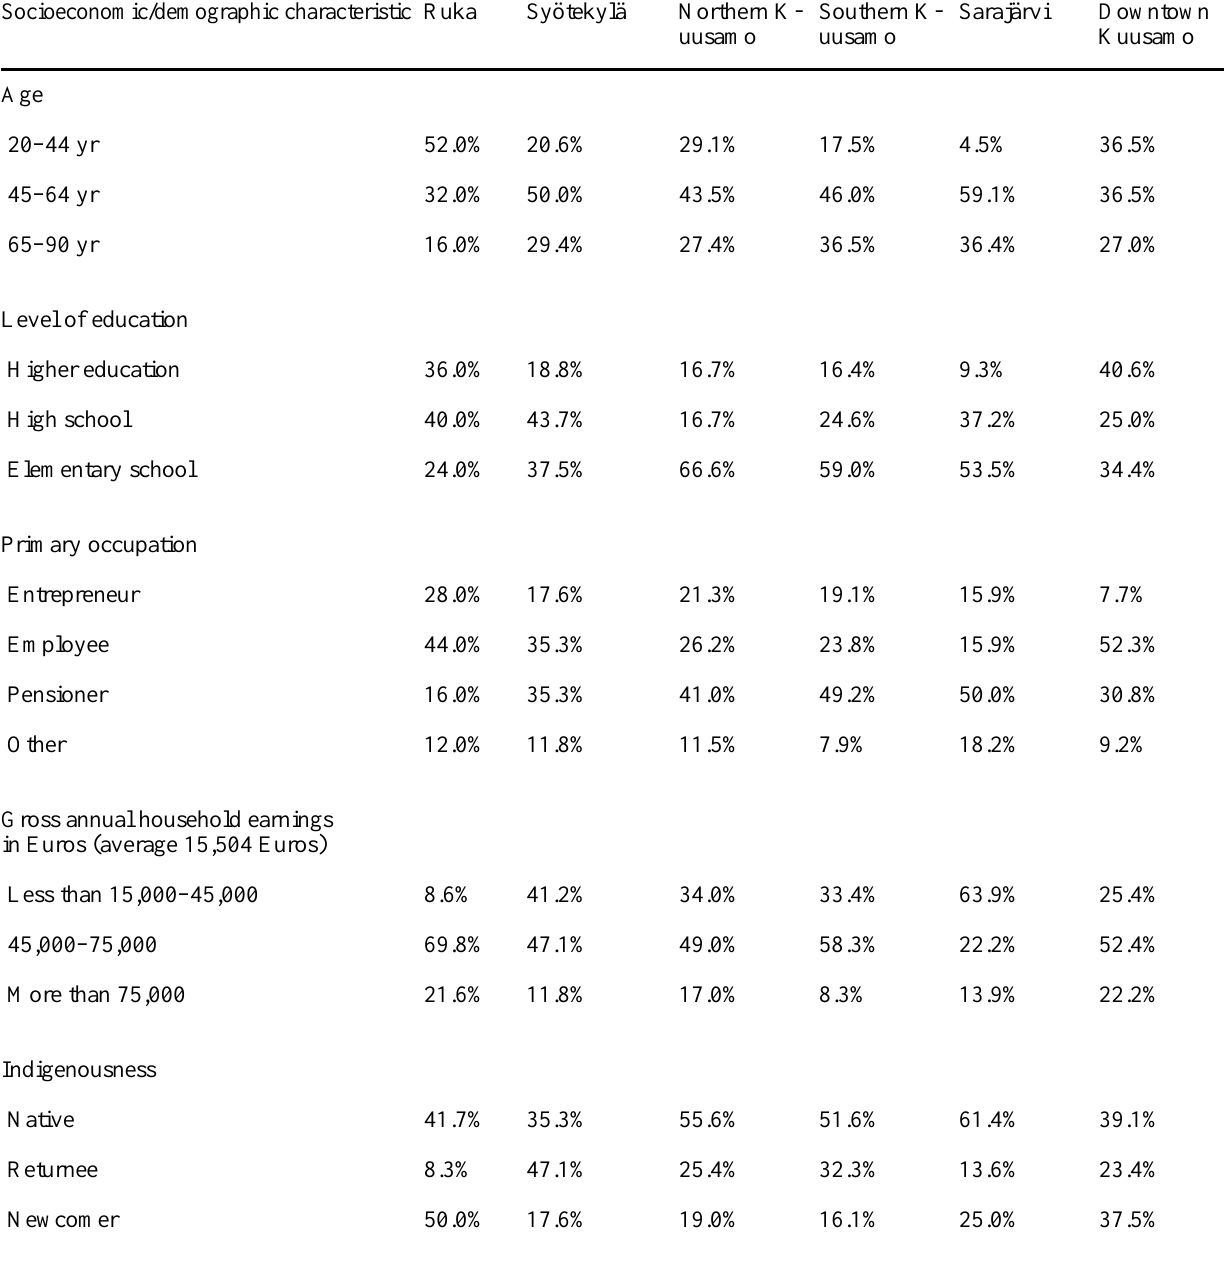
Table 3 . Percentages of respondents with particular socioeconomic and demographic characteristics in different residential areas: Ruka, Syötekylä, northern Kuusamo, southern Kuusamo, Sarajärvi, and downtown